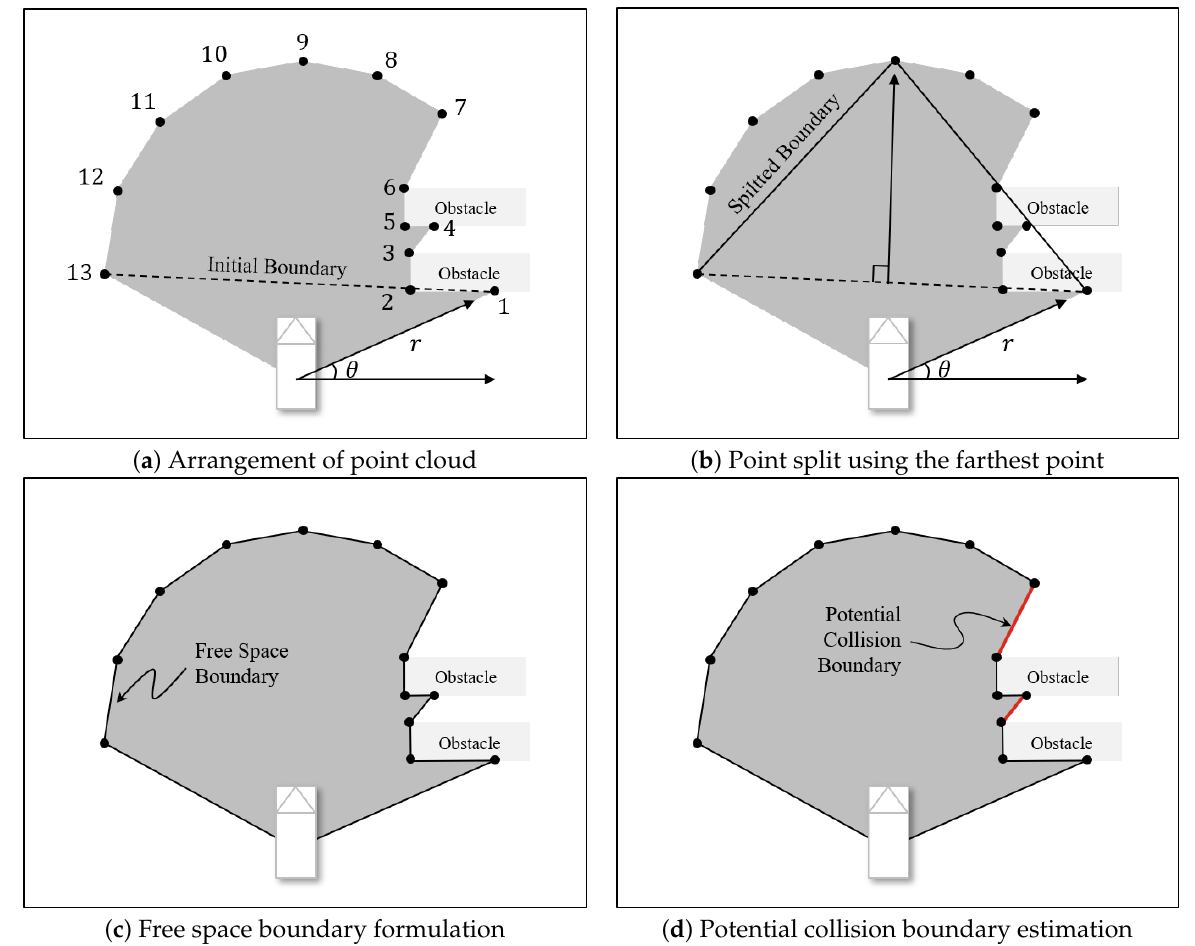
Figure 3. Steps for estimating the potential collision boundary based on candidate